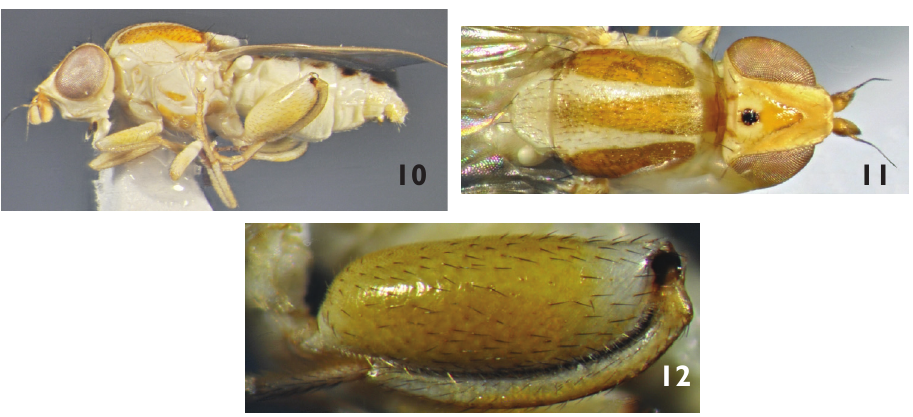
Figure 10–12. Meromyza samsunensis sp. n. (paratype): 10 body lateral view 11 body dorsal view 12 hind femora, lateral (dorsal)